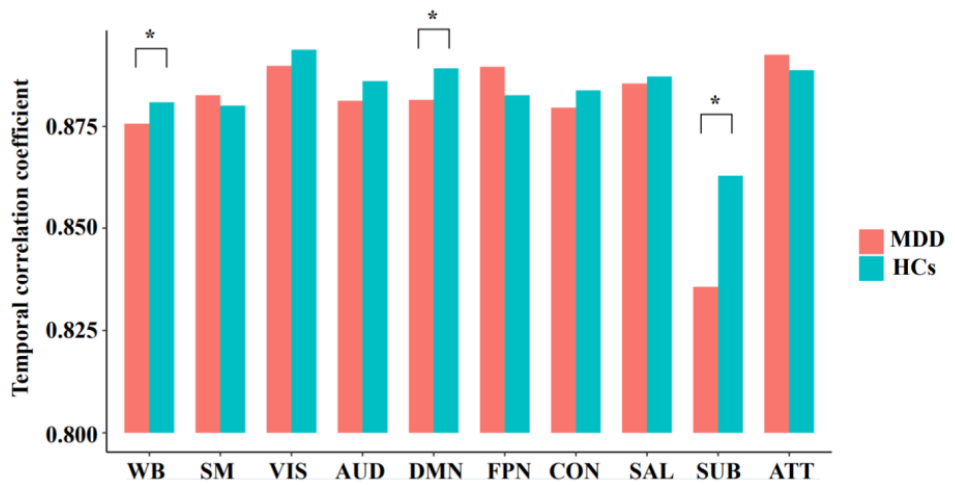
Figure 2. The mean temporal correlation coefficients of the whole brain and each network in the groups of major depressive disorder (MDD) and healthy controls (HCs), after adjusting for age, sex, and education. WB, whole brain; SM, sensorimotor network; VIS, visual network; AUD, auditory network; DMN, default mode network; FPN, frontoparietal network; CON, cingulo-opercular network; SAL, salience network; SUB, subcortical network; ATT, attention network; * significant difference with corrected p < 0.05.